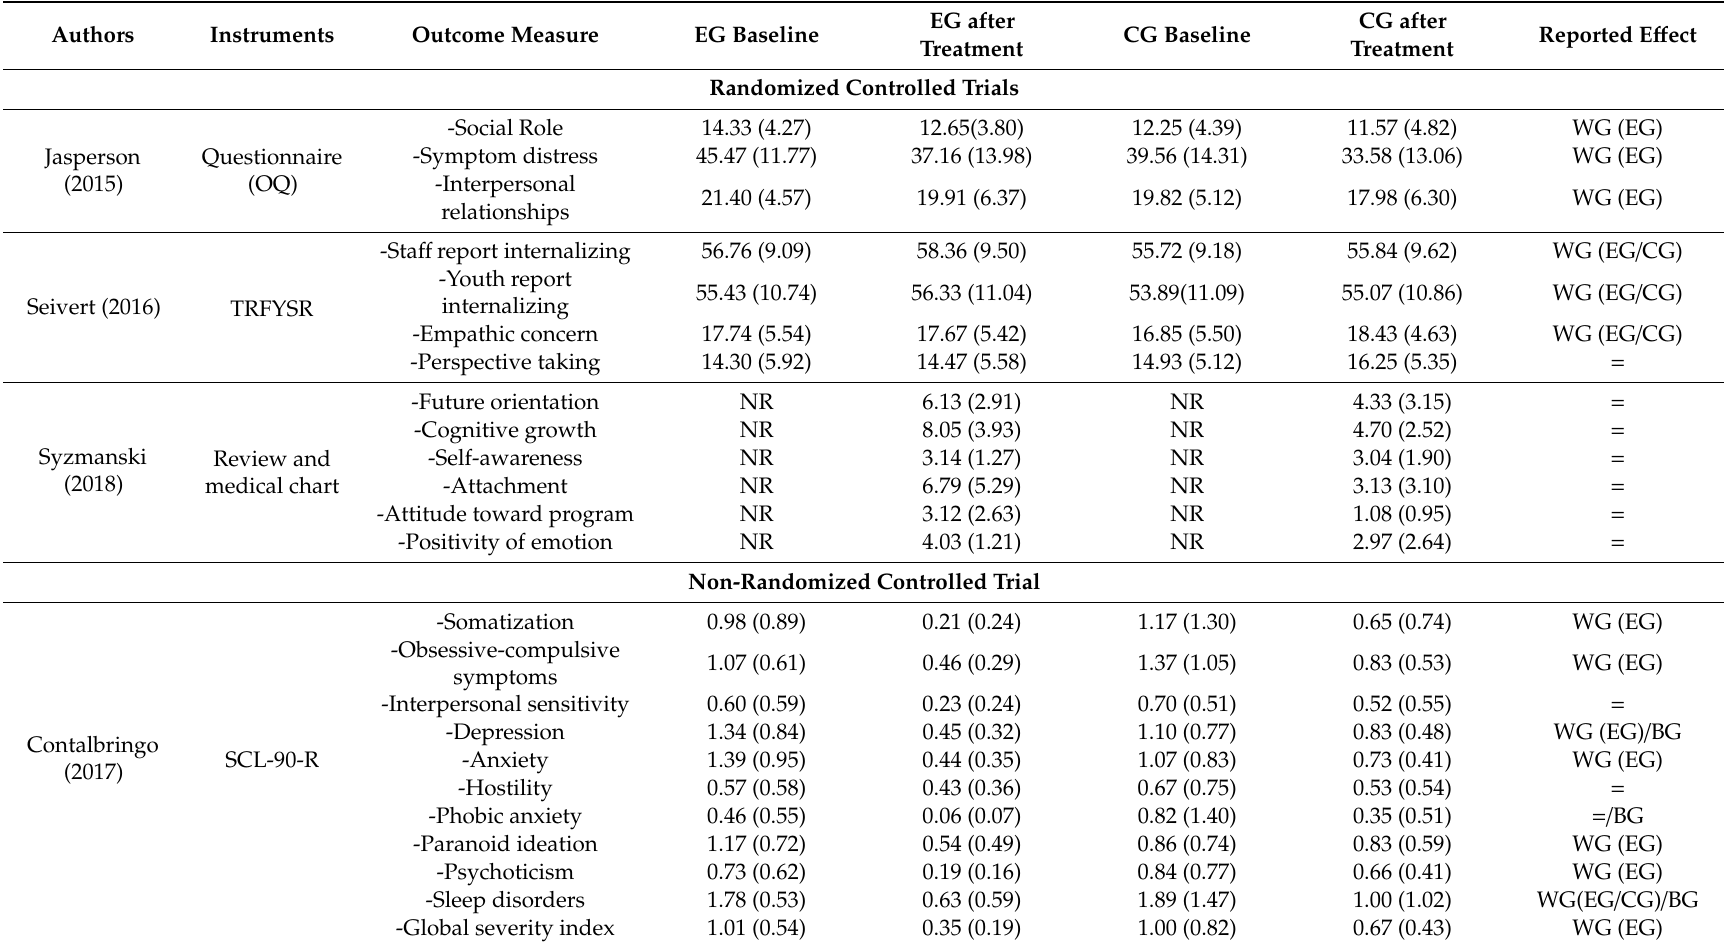
Table 4. Results synthesis of quantitative